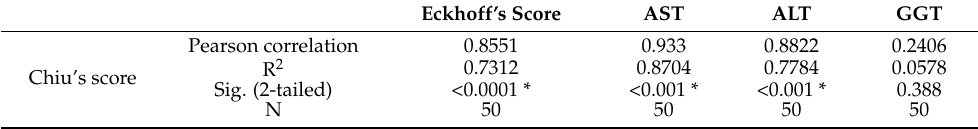
Table 5. Pearson’s correlation between hepatic injury markers and intestinal histomorphological